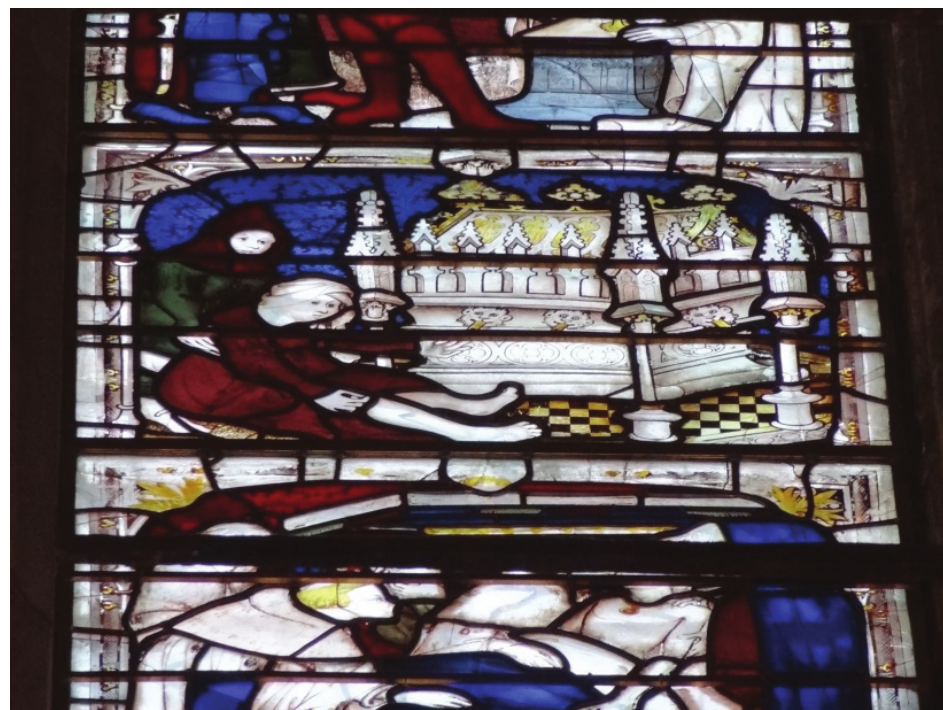
Figure 6: Spigots on Saint William’s sarcophagus at York Minster. Photo © Paul A. Brazinski,